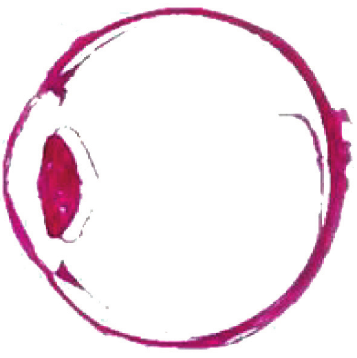
Figure 4: The segmentation results from region-growing algo-